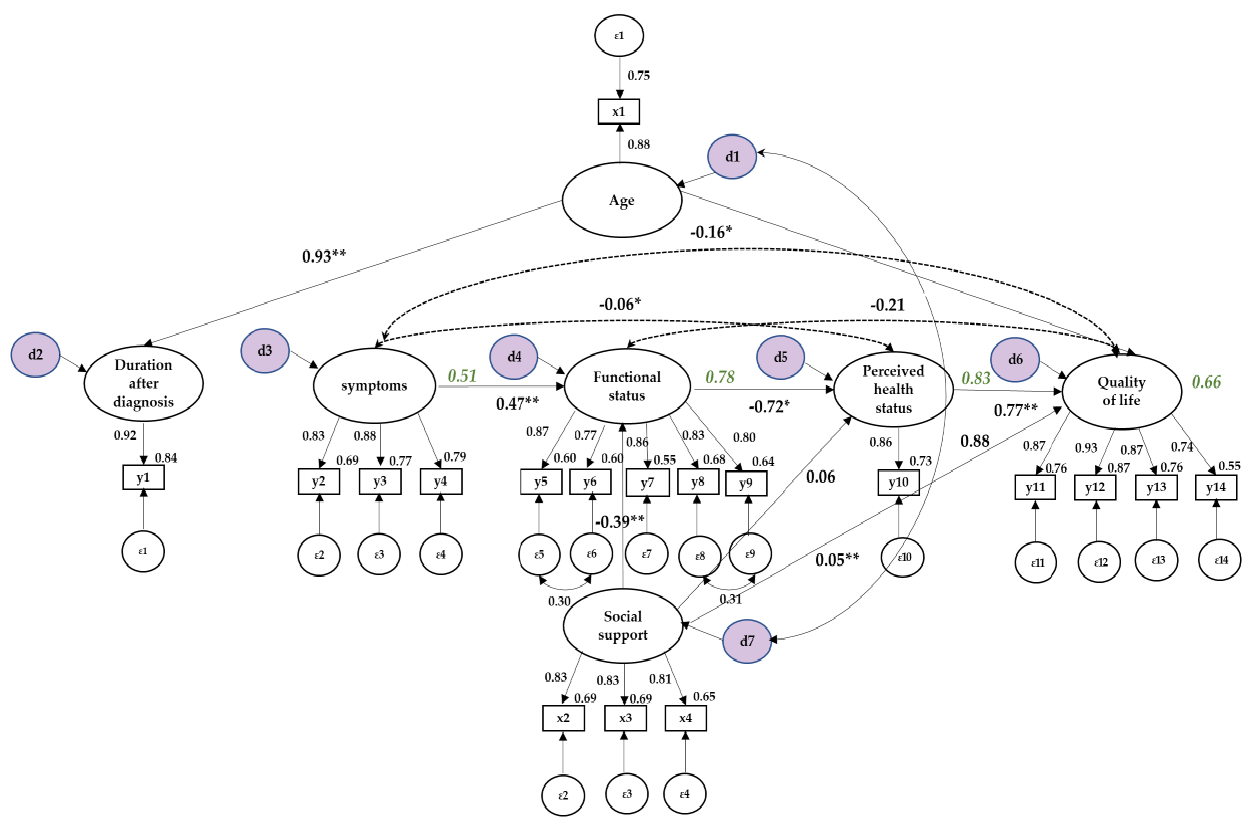
Figure 1. Path diagram for the modified model. * p < 0.05; ** p < 0.01; x1 = Age; x2 =